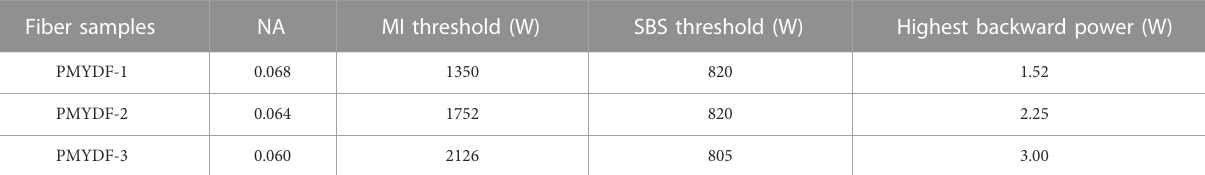
TABLE 2 Results by applying the three different NA